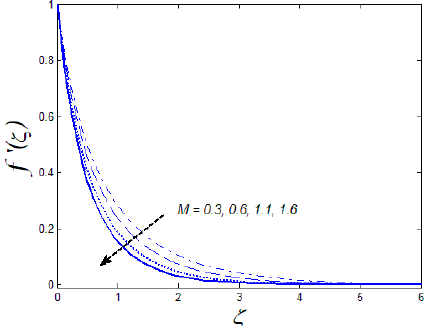
Figure 7. Upshot of M on velocity profile f ′ ( ζ ) .